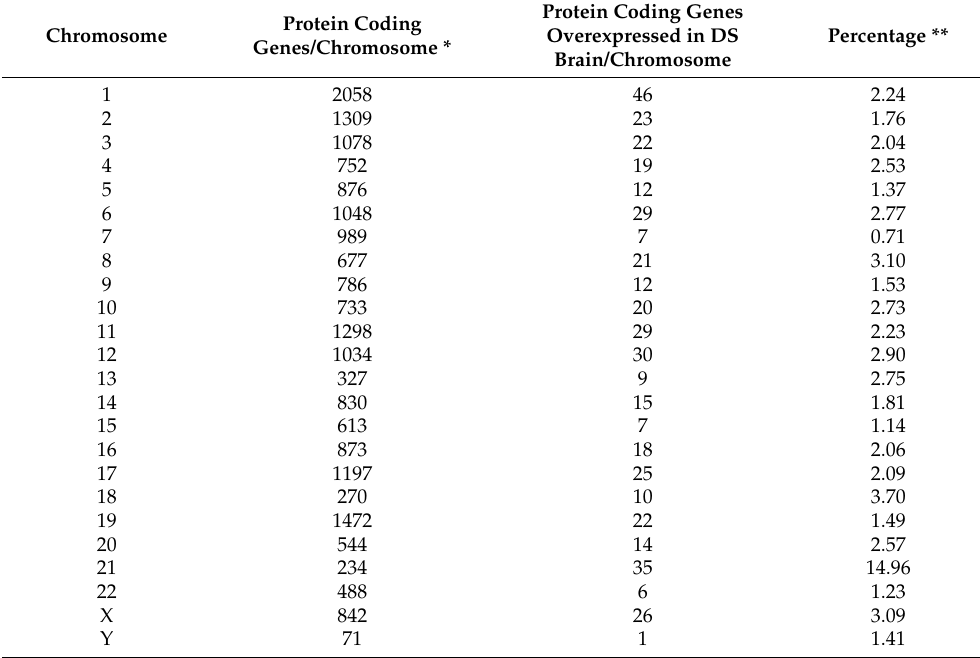
Table 1. Number and percentage of coding protein genes per chromosome which are over-expressed in Down syndrome patients.